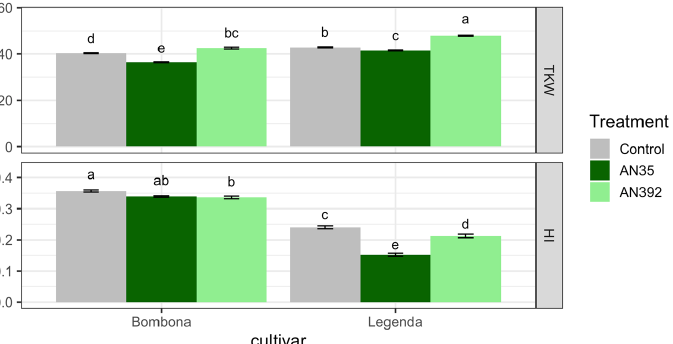
Figure 12. Comparison of TKW and HI in control wheat plants and after Trichoderma root inoculation. Letters indicate significance groups within the row (for each yield parameter) according to Tukey’s test at 0.05.